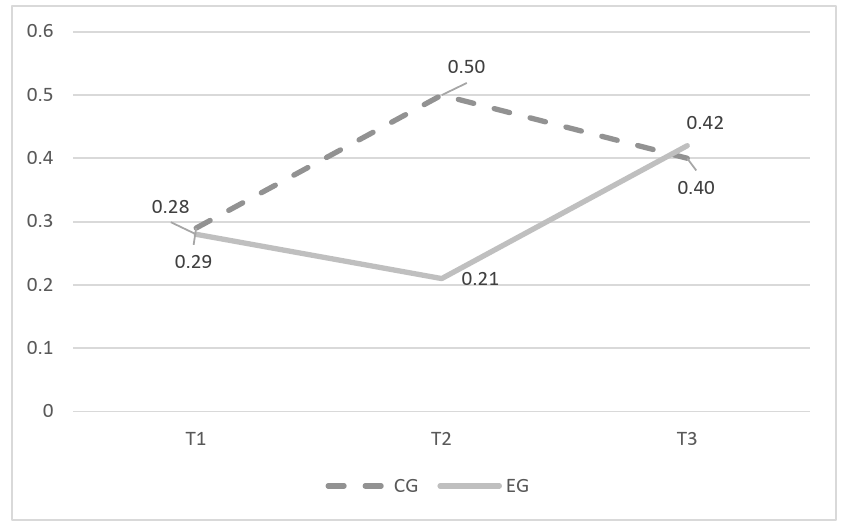
Figure 1. Average scores in cyberbullying over time.